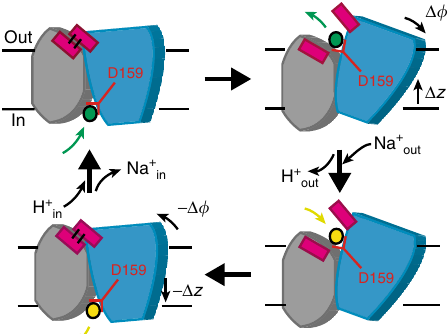
Fig. 5 Transport cycle. To shuttle ions between the inward-open (left) and outward-open conformations (right), the six-helix-bundle transporter domain (blue) translates along z , normal to the membrane, and rotates relative to the core domain (gray) around an axis in the membrane plane. Although the scheme shows the inward transport of Na + (yellow), and the outward transport of H + (green), both carried by Asp159, the transport cycle is fully reversible, and its direction determined by the respective gradients of H + and Na + across the membrane. Coupled to the domain motion, closing of the hydrophobic gate (magenta) prevents ion